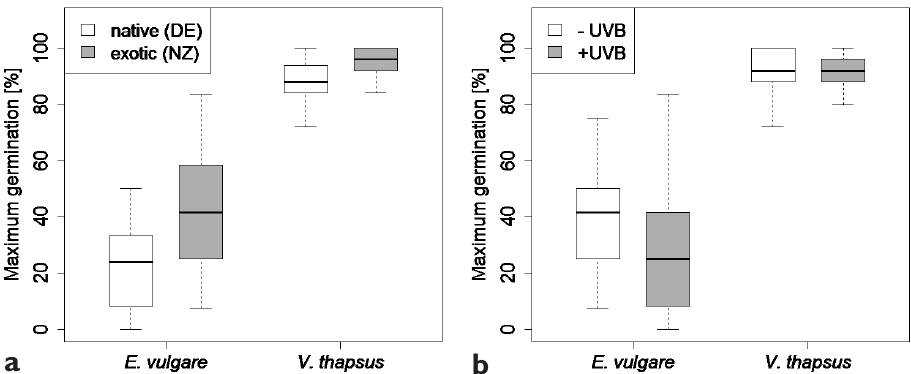
Figure 3. Maximum germination in the within-species approach testing for local adaptation of Echium vulgare and Verbascum thapsus seeds. a of New Zealand (grey) and German (white) populations and b in response to UV-B radiation (grey) and no UV-B radiation (white)